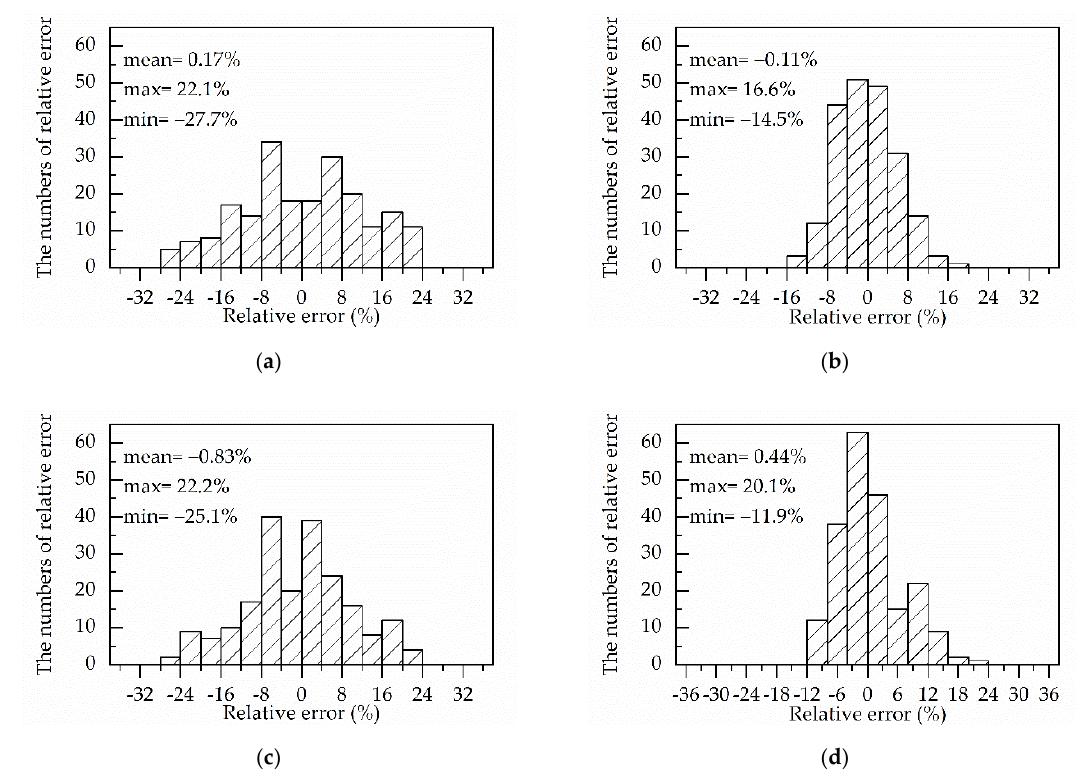
Figure 22. Statistical analysis of the relative error from the ( a ) osA-type equation; ( b ) msA-type equation; ( c ) oHS equation; ( d ) mHS equation.